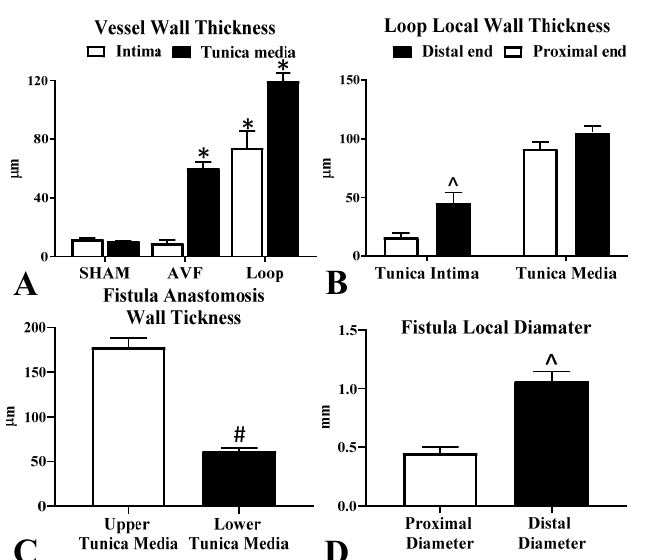
Figure 4. Numerical data of the histological results. ( A ) Comparison of the tissue layers (tunica intima and tunica media) between the groups. ( B ) Comparison of the tissue layers at the proximal and distal ends in the loop. ( C ) Comparison of the upper and lower walls at the AVF anastomosis site. ( D ) Diameter of the AVF at the proximal and distal area. Means ± SEM, n = 10; * p < 0.05 vs. Sham; ^ p < 0.05 vs. proximal end, # p < 0.05 vs. upper wall.